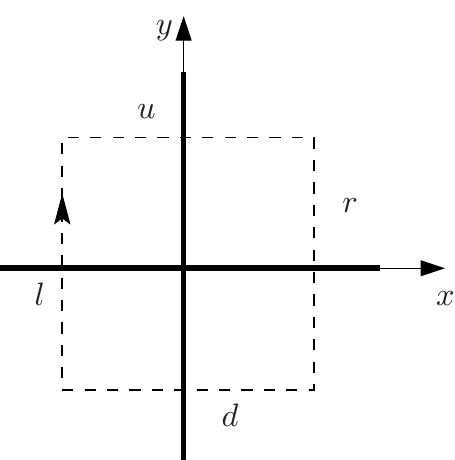
Figure 3. The thick segments represent the paths L x and L y used in the regularization of the basic FIG. 3: The thick segments represent the paths L and L used in the regularization of the basic observables x y observables used in (49). The square-oriented path represents the contour C used in (67) defined by used in (48). u , d , r , l four oriented segments . The diagram should be thought of as embedded inside a coordinate { } (cid:101) 2 . The regularisation is removed in the limit (cid:101) ball x 2 + y 2 ≤ →